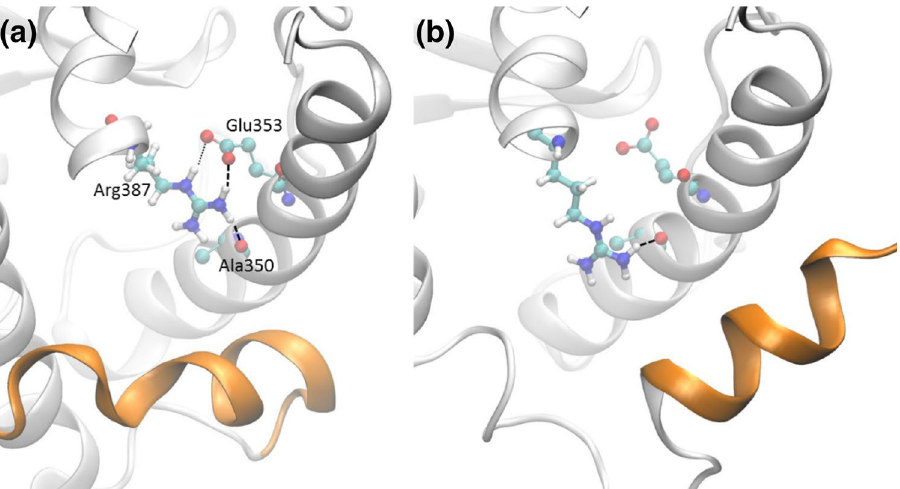
Figure 3. Formation of hydrogen bonds between the mutant residue 387 with other residues within the helix 3 (H3) at the active ( a ) and inactive ( b ) states. At the active state, Arg387 forms one stable hydrogen bond (bold dashed lines) with residues Ala350 and Glu353 each, and an additional one (light dotted line) with Glu353, which appears in ~ 65% of the entire simulations. At the inactive state, the side chain of Arg387 only forms one stable hydrogen bond with Ala350 (side chain of Glu353 forms hydrogen bonds with Arg394 instead, with 126% frequency of occurrence; the frequency is 15% in the active state). The helices H4, H8 and H9 are removed from both figures for reasons of